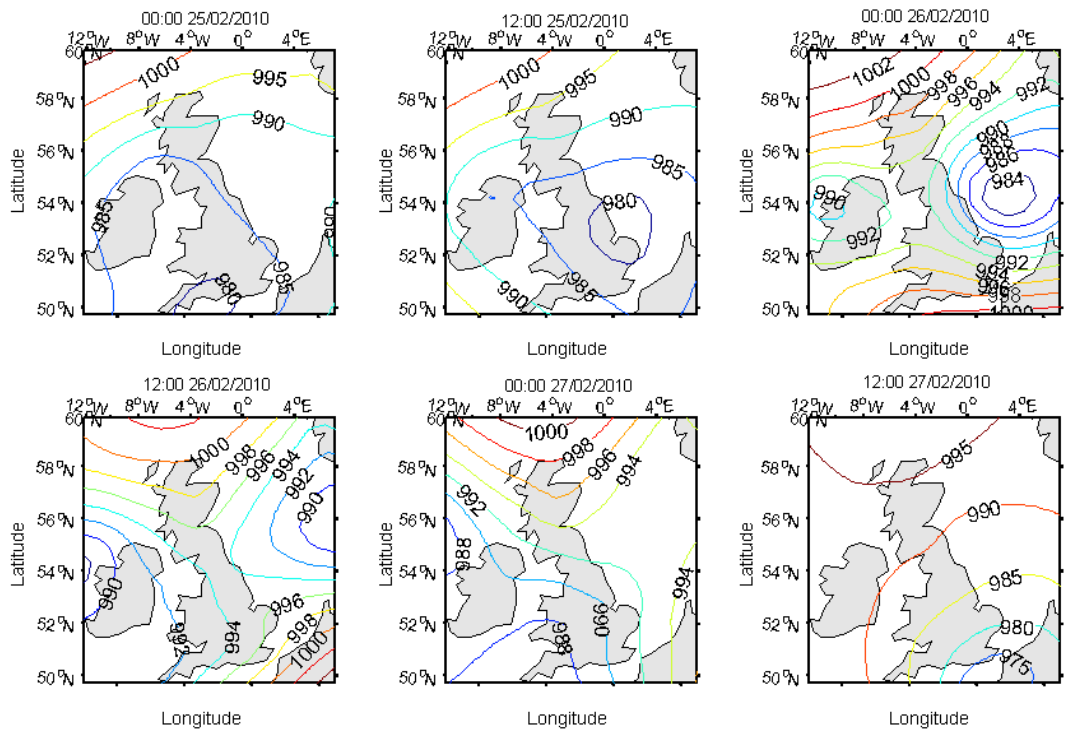
Figure 7. The mean sea level pressure fields (hPa) before and during the 25–26 March 2010